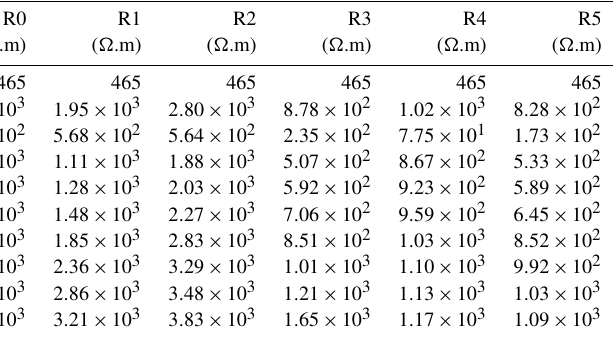
Table 1. Summary statistics of the time series variable.